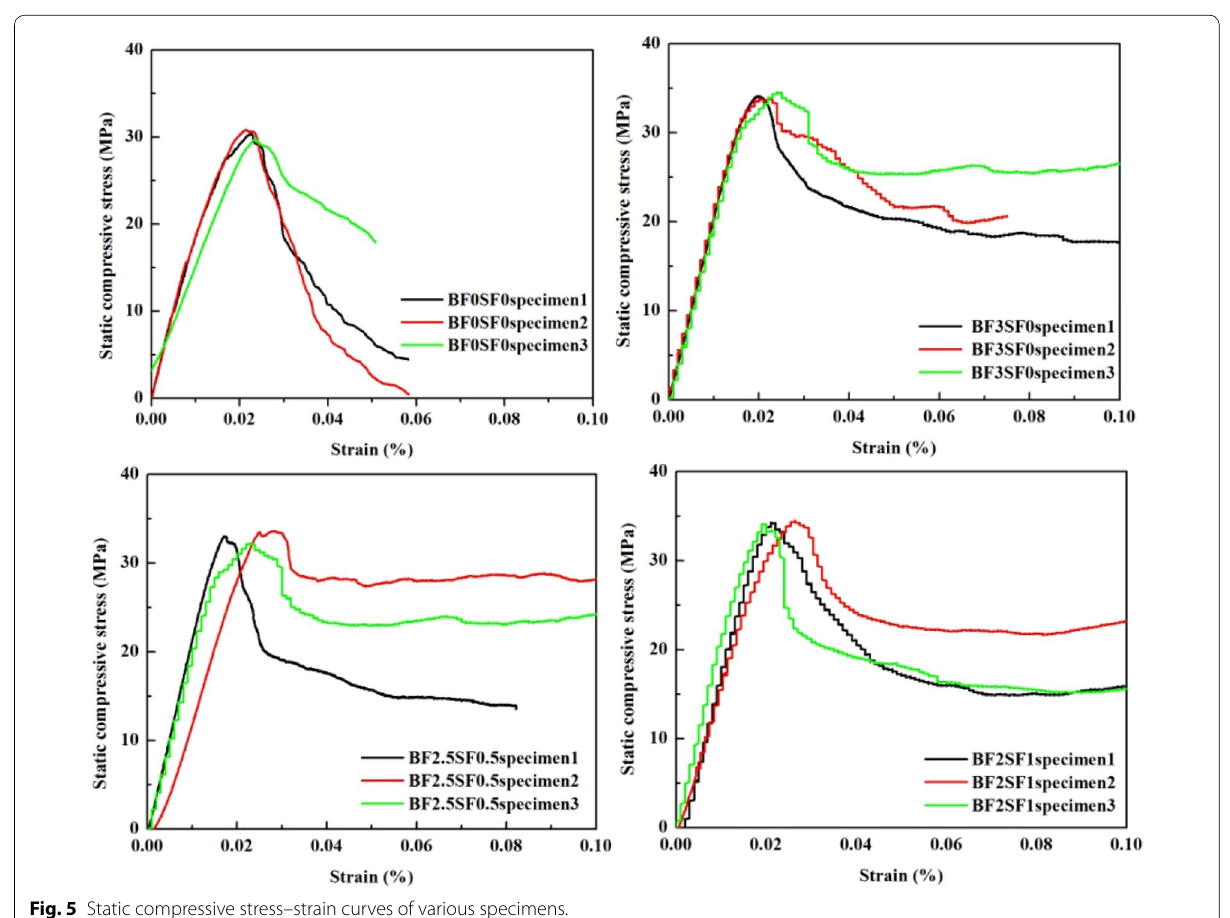
Fig. 5 Static compressive stress–strain curves of various